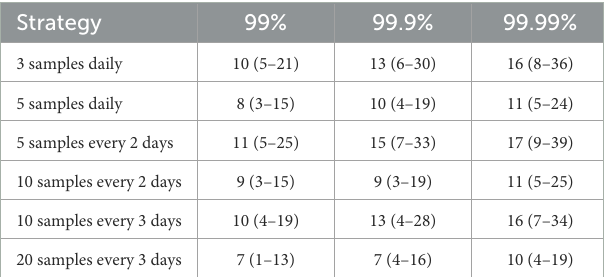
TABLE 2 Median number of days (and 95% credible interval) surveillance is required for to have different % probability of detection where sampling starts on a random day after first infection, given by Figure